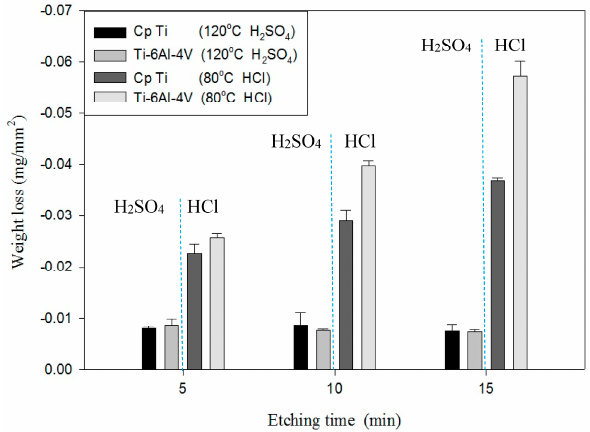
Figure 4. The comparison of the weight loss of Ti/Ti-6Al-4V ELI for different etchant solutions after etching at RT. Materials 2017 , 10 , 1164